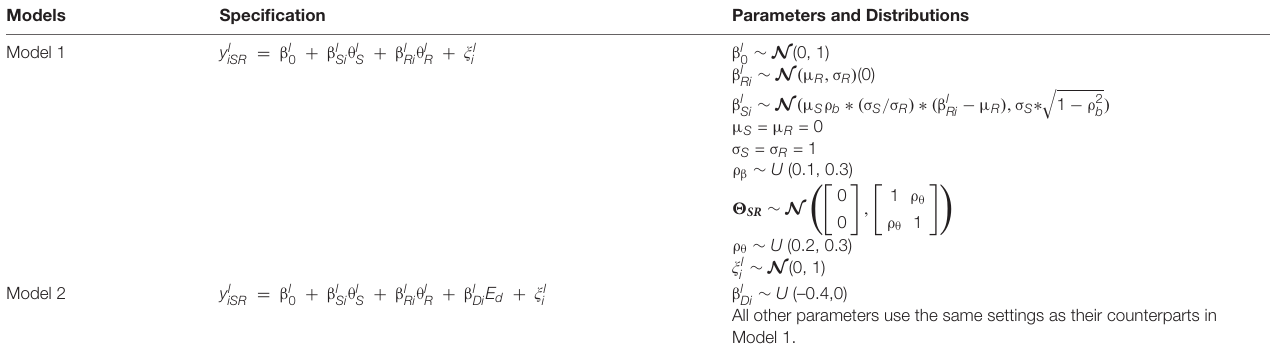
TABLE 2 | Model specifications and parameter settings for data generation.